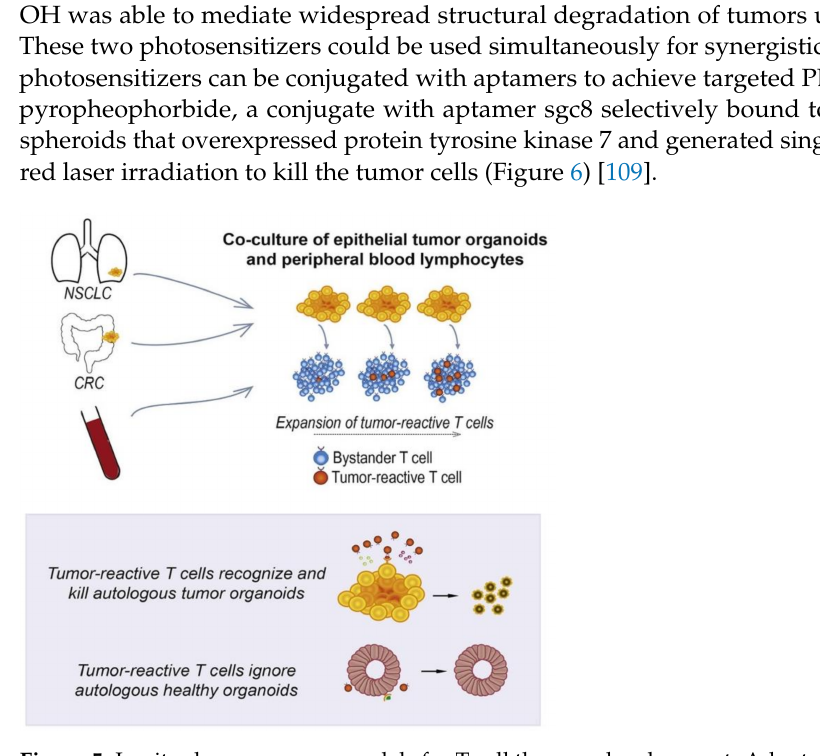
Figure 5. In vitro human cancer models for T cell therapy development. Adapted with permission from [103] © Elsevier (2018).